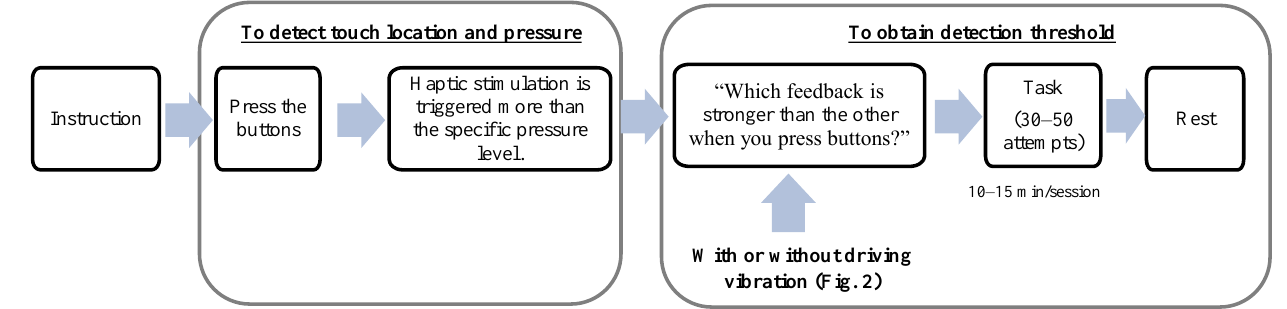
Figure 4. Experimental design paradigm for data